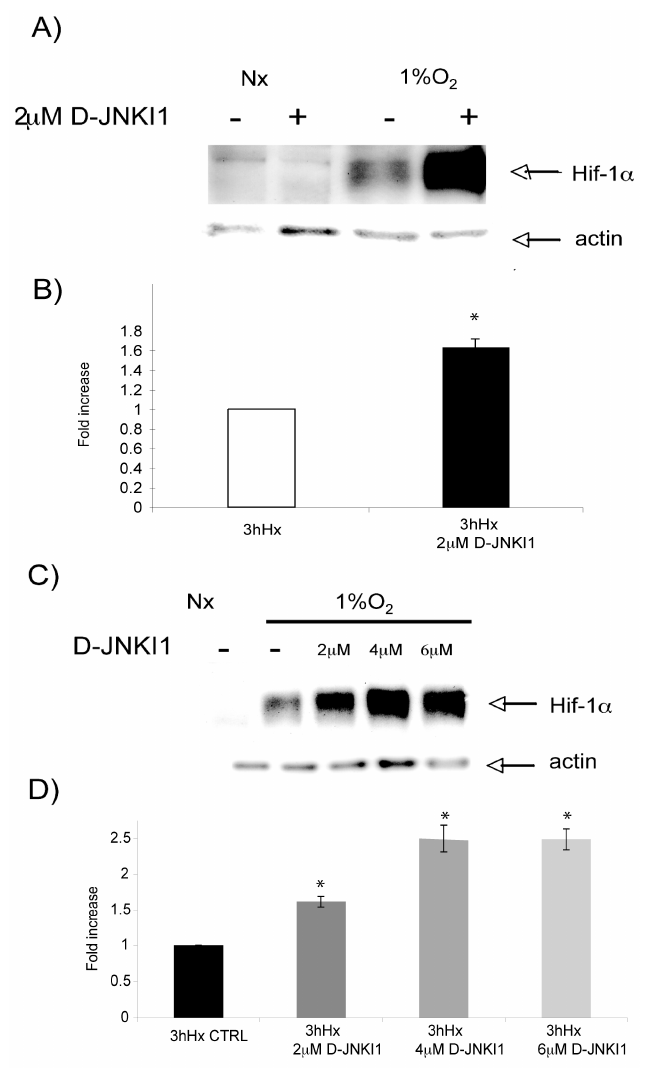
Figure 6. D -JNKI1 increases hypoxia-induced Hif-1 α expression. A) Representative Western blot of Hif-1 α after hypoxic exposure shows D -JNKI1 (2 μΜ) increases hypoxia- induced Hif-1 α expression. B) Quantification analysis confirmed that